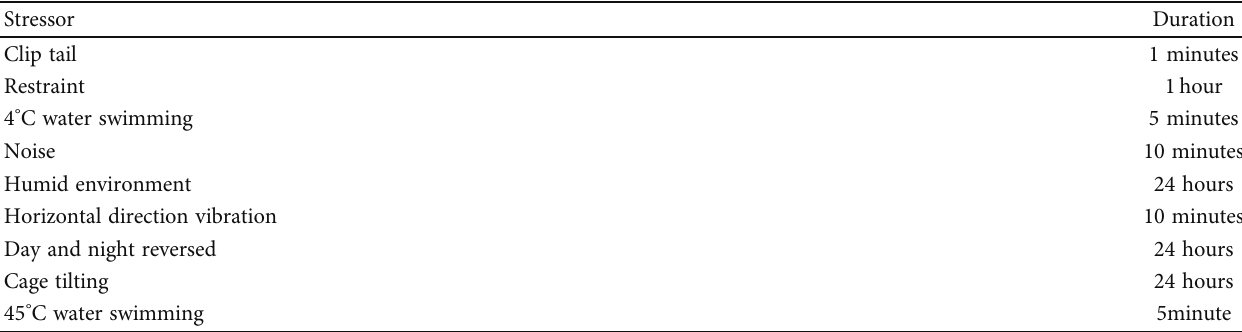
Table 1: The stressors of CUMS.